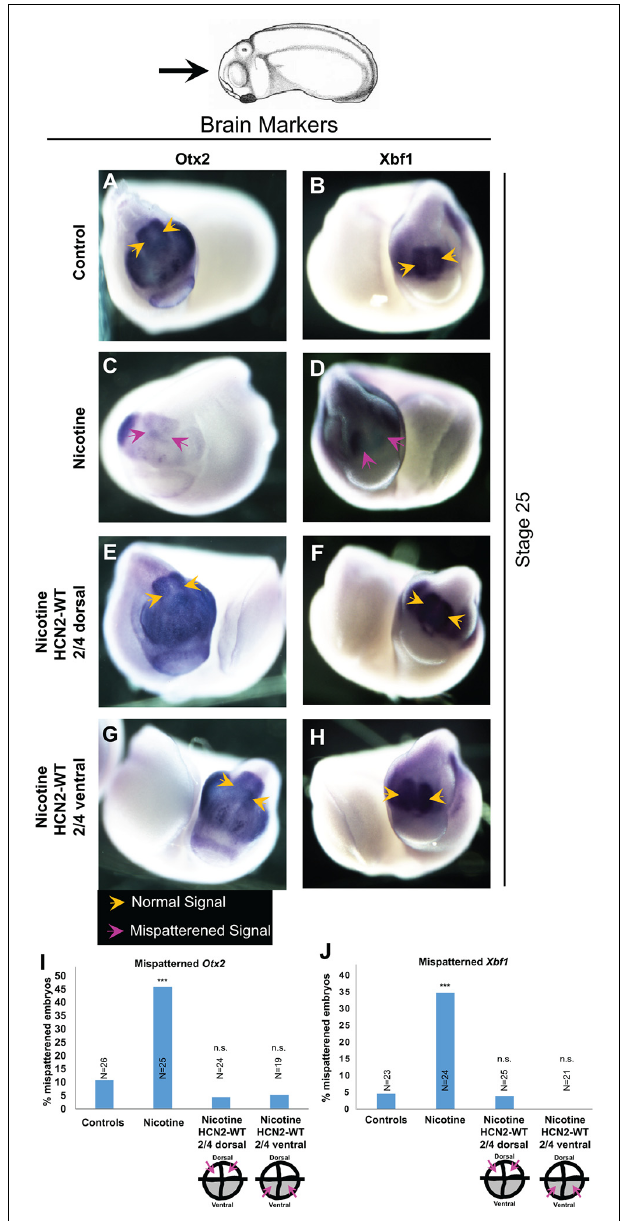
FIGURE 3 | Both local (CNS) and distant (non-CNS) HCN2 channel expression restore nicotine exposure-induced mispatterning of brain markers during neural development. (A–H) Representative images of stage 25 embryos as illustrated with the angle of view marked by the black arrow. in situ hybridization with digoxigenin-labeled antisense, riboprobes were used to detect Otx2 and Xbf1 in the indicated experimental groups. Yellow arrows indicate normal expression pattern and magenta arrows indicate significantly mispatterned expression. (I,J) Quantification of in situ hybridized embryos for Otx2 ( N ≥ 25 embryos for each experimental group) and Xbf1 ( N ≥ 20 embryos for each experimental group) from n = 3 independent experiments pooled together. Data are represented as mean with χ 2 squared test for differences in proportions, *** p < 0.001, n.s.: